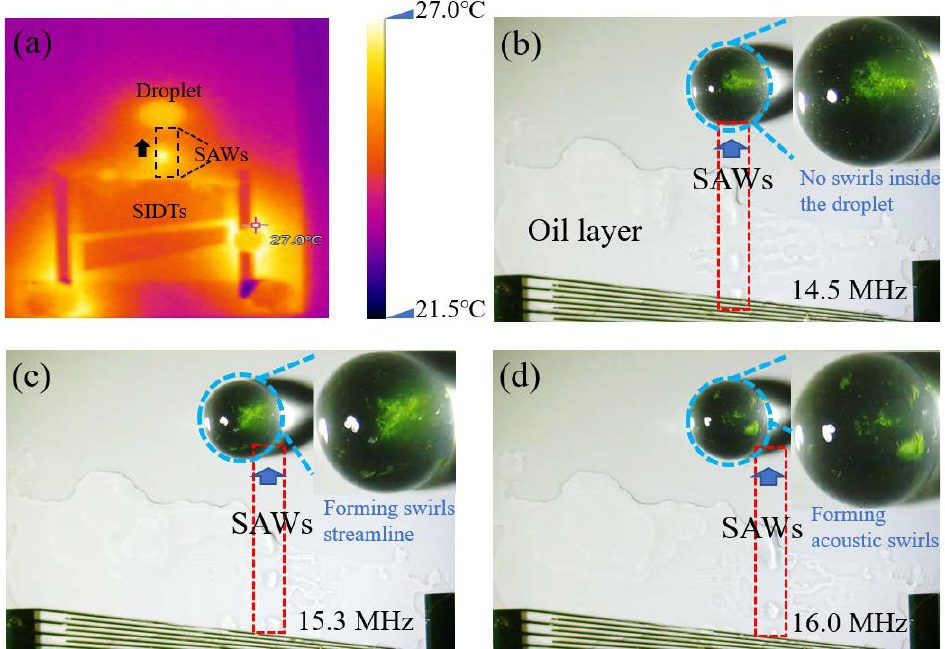
Figure 3. ( a ) Narrow beam of the SAWs photograph taken with a thermal imager. Where the droplet volume is 8 µ L. ( b – d ) Scattering of SAWs inside the droplet from three different locations after propagation in the oil layer, and SAWs entering the droplet from the center of the droplet ( f ≈ 14.5 MHz), the center of the right half ( f ≈ 15.3 MHz), and the edge of the right half ( f ≈ 16.0 MHz), respectively. SAWs meeting the droplet in different positions produced different swirl intensities.